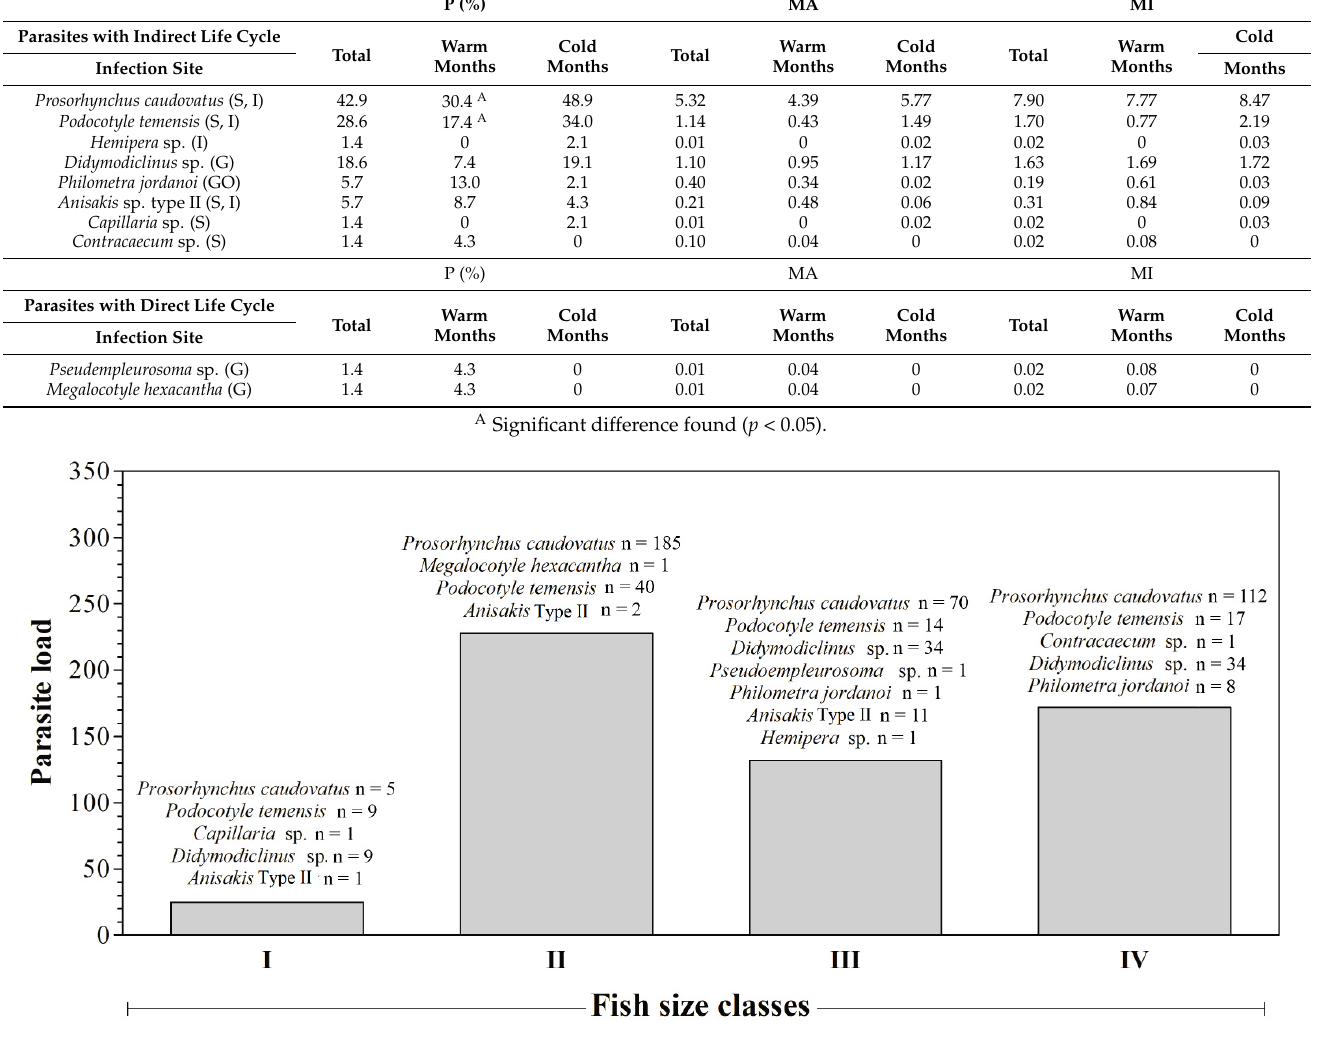
and cold months. Biometric data, including weight and TL of E. marginatus investigated in the current survey, were positively correlated with the parasitic load of P. jordanoi and Didymodiclinus sp. (Table